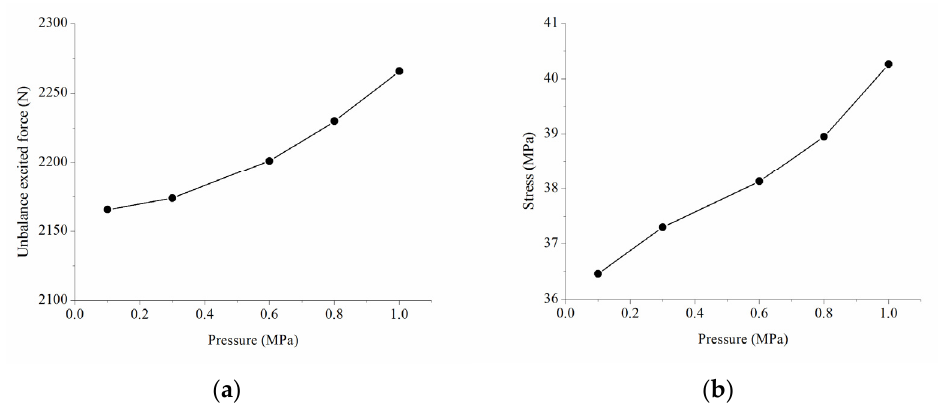
Figure 15. Unbalanced exciting force and stress of RC1-B4 under different pressures ( a ) Unbalanced exciting force; ( b ) Stress.